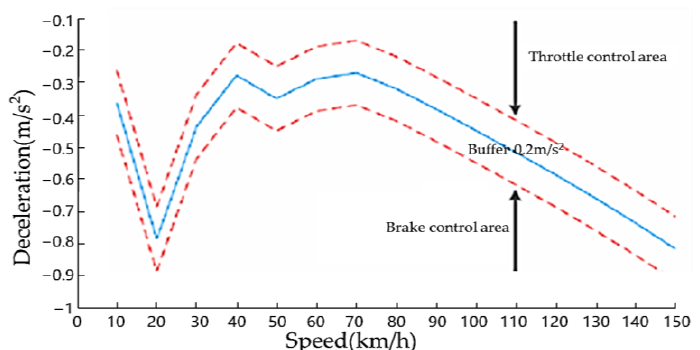
Figure 2. Maximum deceleration under different vehicle speed conditions with zero throttle open-